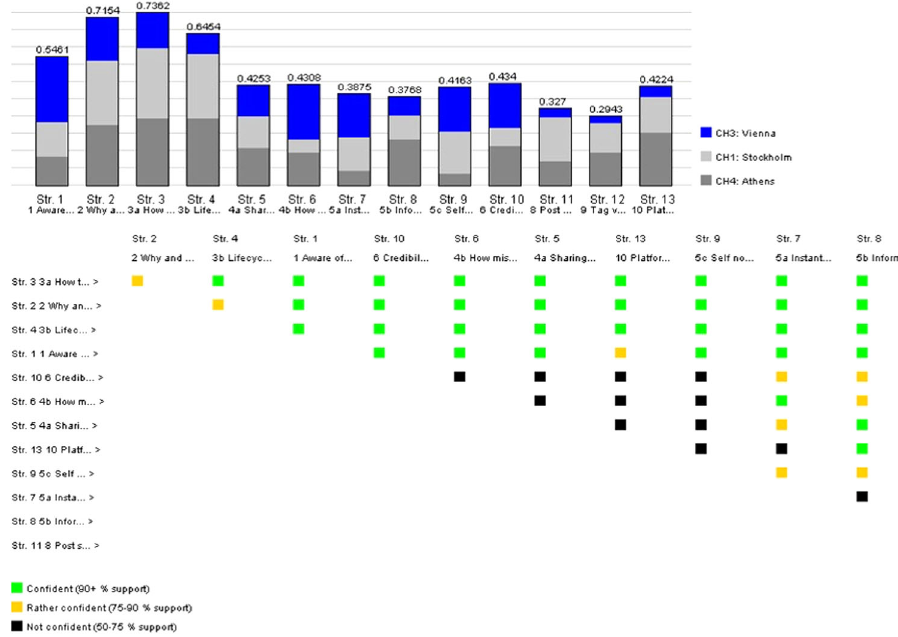
Fig. 4 Policymakers preferences in Vienna and Athens. Preferences. Table 5 Preferences of the three stakeholder groups in Austria, Greece and